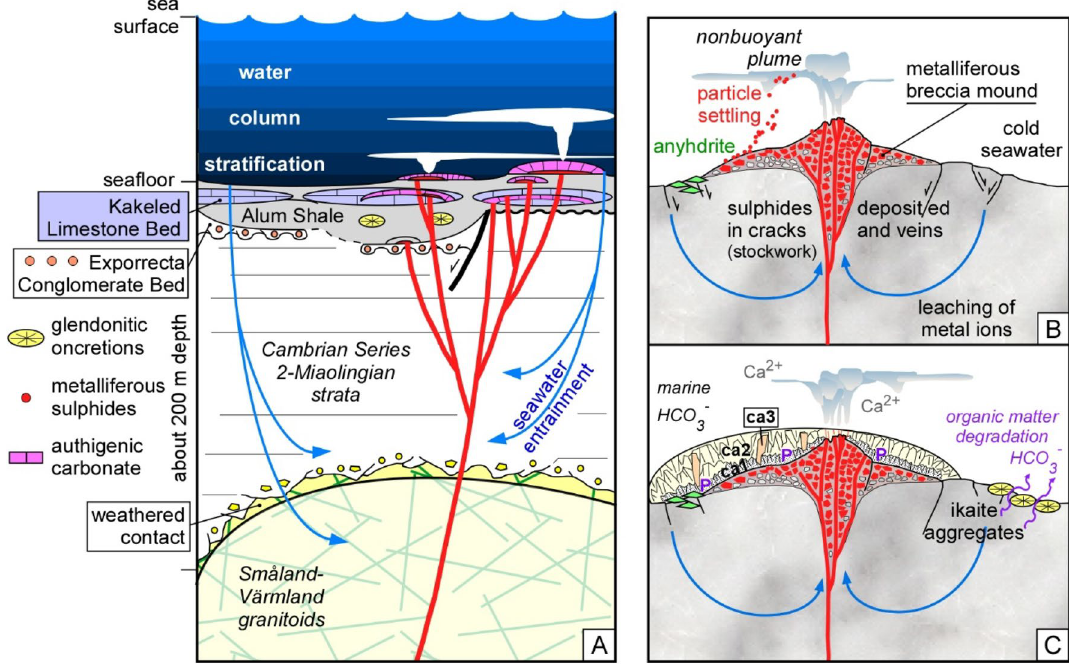
Figure 8. (A) Schematic drawing of the Öland hydrothermal system encased in the Alum Shale Formation showing the different components and processes described in the text. ( B) First phase characterized by deposition of pyrite, galena and chalcopyrite as vein stockworks, reworked angular clasts and particle settling from a nonbuoyant plume, triggered by vigorous venting of slightly acidic hydrothermal fluids with temperature > 100 ºC. ( C) Second phase of a metalliferous carbonate mound, influenced by slightly alkaline hydrothermal fluids below 100 ºC, and showing overlying crusts of turbid ikaite (now ca1 ) rich in phosphate ( P ), limpid aragonite (now ca2 ), and recrystallized crystals of calcite that also occur occluding fissures ( ca3 ). The hydrothermal system is separated from hydrothermal-free substrates of kerogenous shales encasing ikaite (now glendonitic) concretions recording distinct carbon isotope values controlled by thermal degradation of the organic matter.